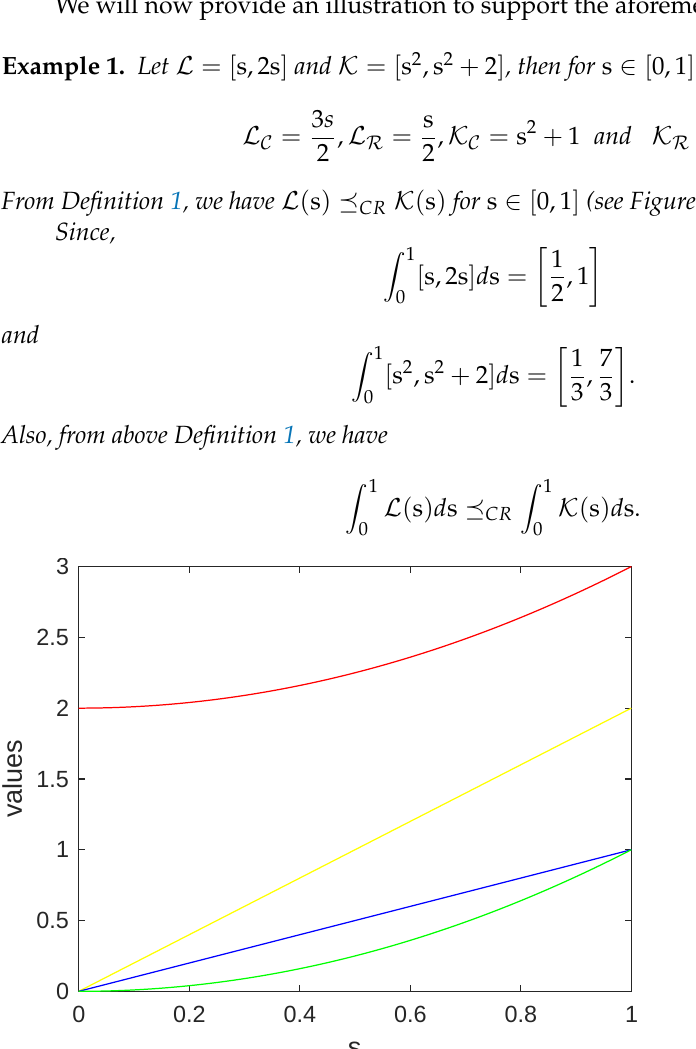
Figure 1. As shown in the above figure, s 2 + 2 is shown as a red, 2s is shown as a yellow, s is shown as blue and s 2 as a green line, respectively. A clear indication of the validity of the CR-order relationship can be seen in the